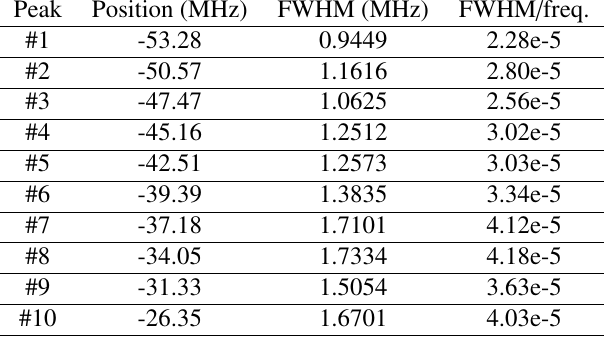
Table 2: Results of Gaussian fitting for the fine structure of the ω pe bursts shown in Figure 7(b), and the frequency of the emission is the summation of the number in the column "Position", the carrier wave frequency of the real- time spectrum analyzer (7.5 GHz), and the LO frequency of the radiometer (34